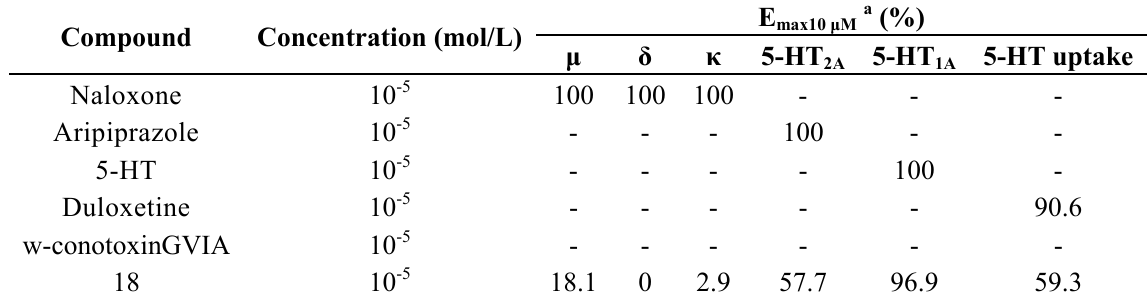
Table 7. Inhibition of the compounds for the relatively